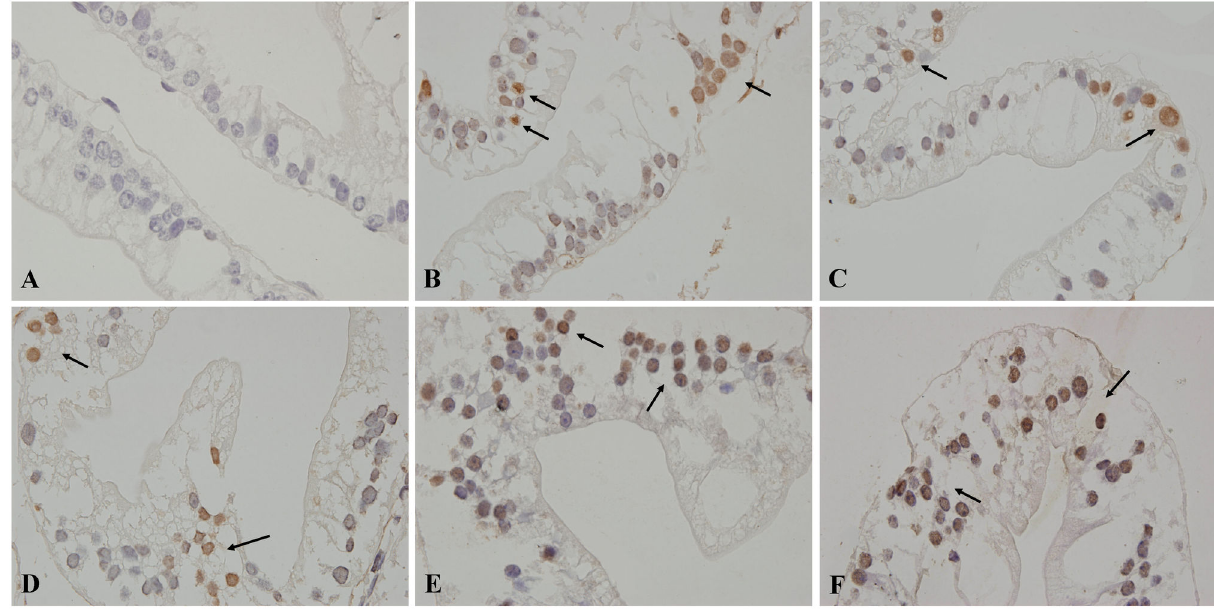
Figure 2. TUNEL assay for detection of the effect of Cd on hepatopancreas apoptosis in S. henanense ( n = 4). ( A ) Control group. ( B ) 3.56-mg/L group. ( C ) 7.12-mg/L group. ( D ) 14.25-mg/L group. ( E ) 28.49-mg/L group. ( F ) 56.98-mg/L group. The apoptotic cellular nucleus was stained brown, ×600. The positive cells were dispersedly distributed or clustered. doi: